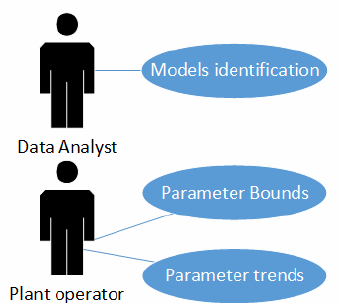
Figure 6. Main use cases diagram.